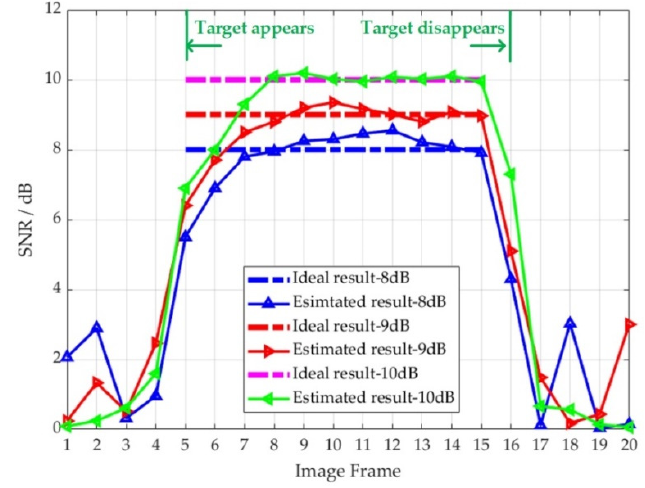
Figure 9. The online estimated signal-to-noise ratio (SNR) results for SNR k , i = 8, 9, and 10 dB.